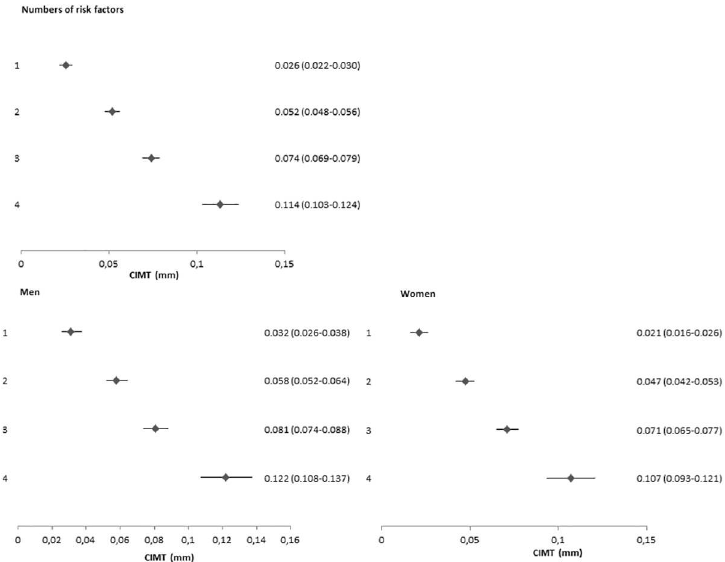
Fig 1. Relation between numbers of risk factors and difference in CIMT (Overall and by sex). Each numberof risk factors was comparedto individuals without any risk factor (referencegroup). CIMT, mean common carotid intima media